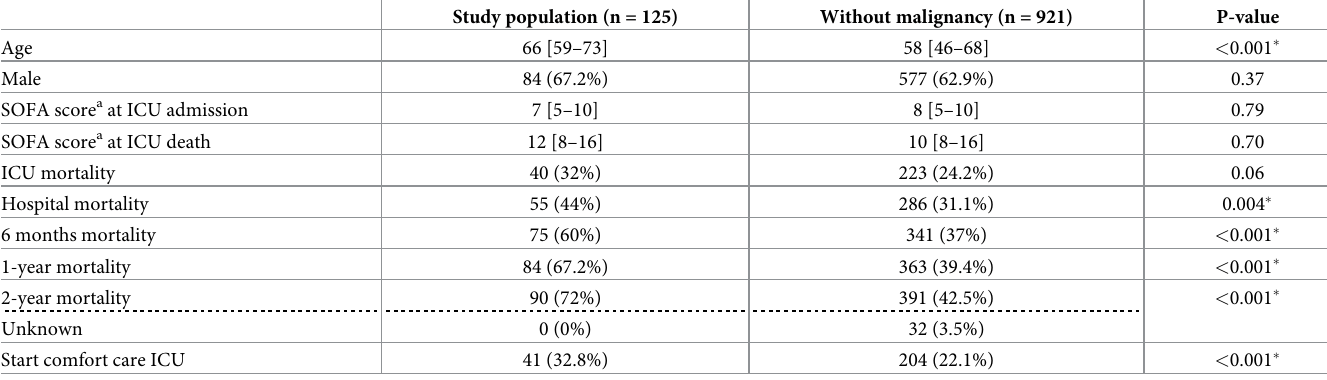
No differences in mortality and ECOG performance status after ICU admission between patients with an active malignancy and patients in CR were seen (S6 Table). While long-term mortality was significantly higher in patients in CR than in patients without a malignancy, no statistical difference in short-term mortality was seen (S7 Table). Table 3. Characteristics and outcome of study population compared to population without